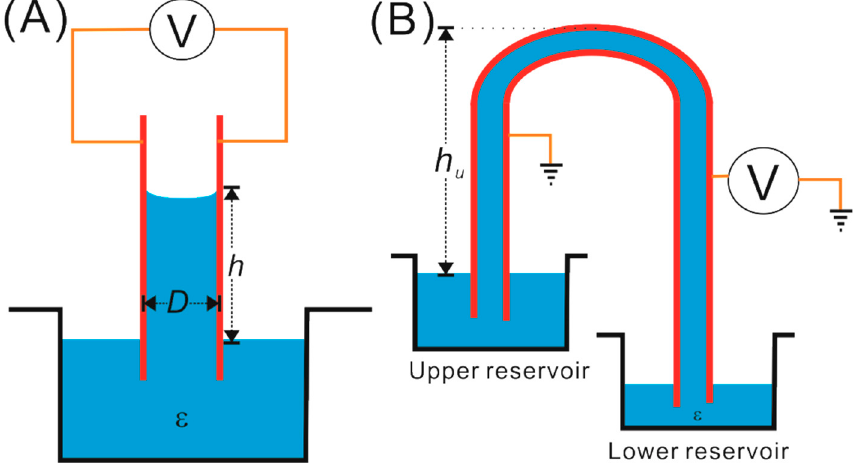
Figure 1. Schematic representation of ( A ) Pellat’s classic experiment of dielectric liquid actuation against gravity by a non-homogeneous electric field, and ( B ) dielectric siphon.